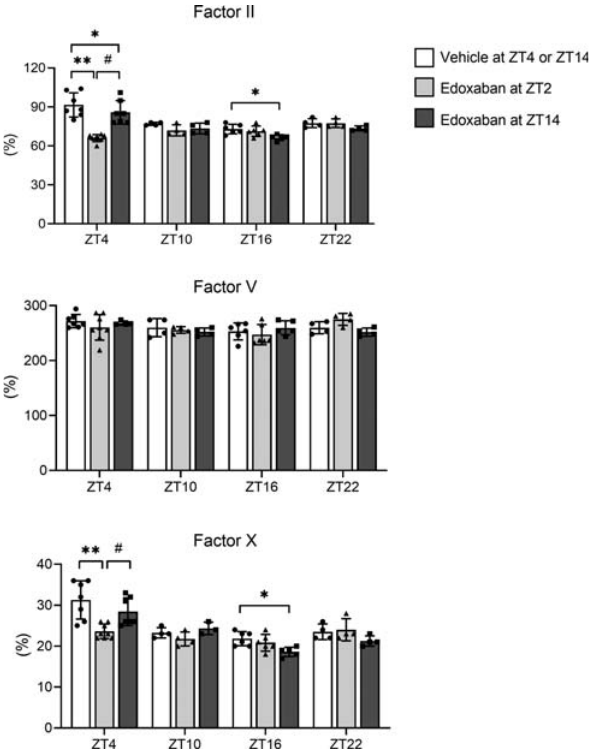
Fig. 2 Dosing time-dependent effects of edoxaban on coagulation factor activity. Rats were administered vehicle solution or edoxaban (10mg/kg) at zeitgeber time (ZT)-2 (light gray bars) or ZT14 (dark gray bars). Blood samples were obtainedat 2, 8, 14, and 20hours after dosing (i.e., at ZT4, ZT10, ZT16, or ZT22 for dosing at ZT2; at ZT16, ZT22, ZT4, or ZT10 for dosing at ZT14). The plasma activities of factors II, V, and X were compared at each time point. The combined data from vehicle-administered rats at ZT2 or ZT14 are shown (white bars). The data represent the mean (cid:3) standard deviation ( n ¼ 4 – 8). (cid:4) p < 0.05, (cid:4)(cid:4) p < 0.01 versus that of the vehicle-administered group at the same ZT. # p < 0.05 versus edoxaban dosing in the ZT2 group at the same